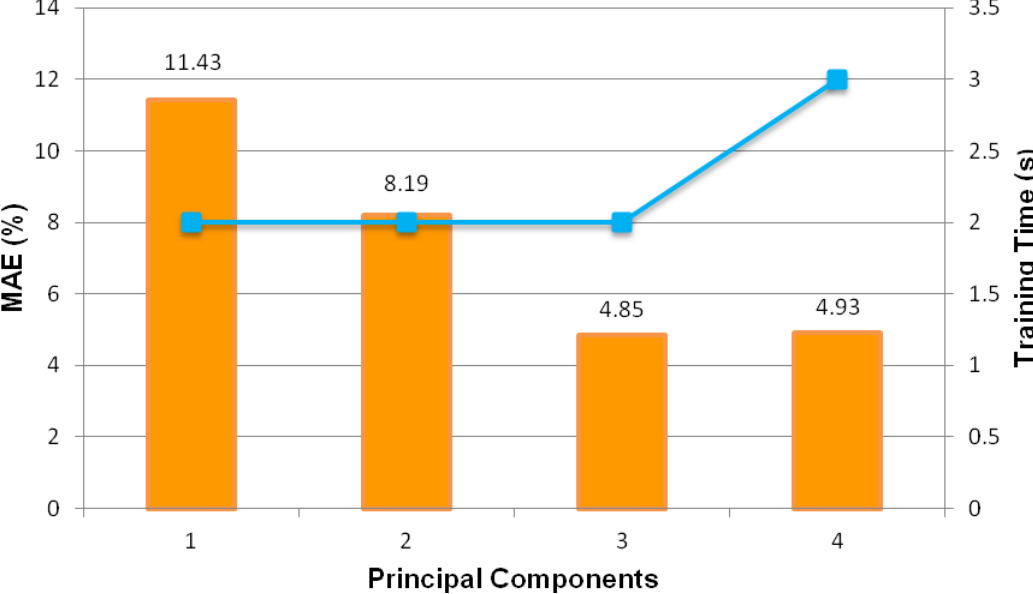
Figure 13. Test set MAE values and training times of MLP trained with one to four principal components.